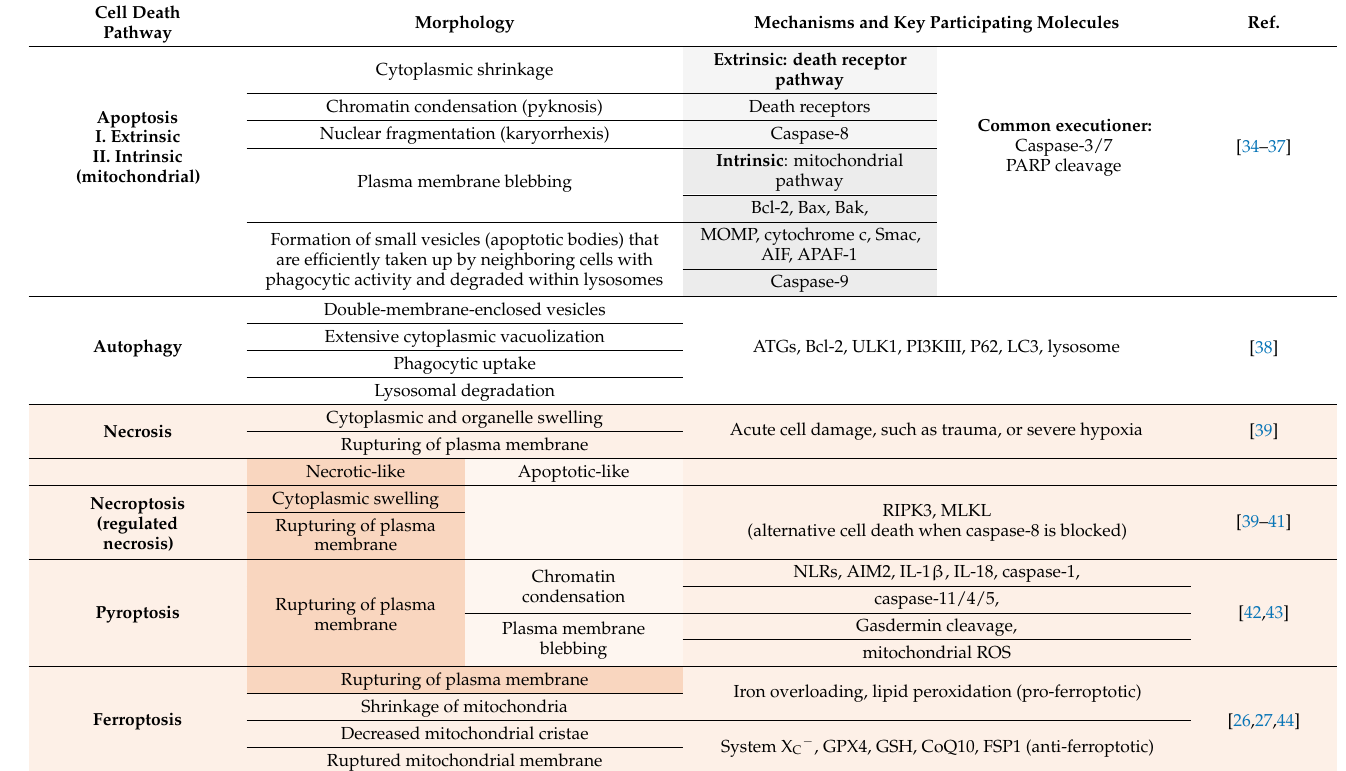
Table 1. Cell death modalities, their morphological features, and key participants.